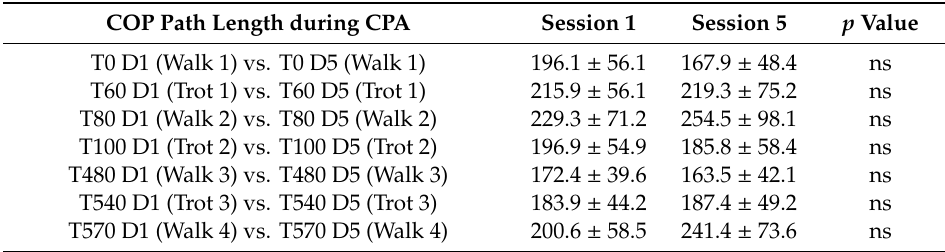
Table 3. Comparison of COP path length and COP average radial displacement values during compensatory postural adjustment (CPA) between corresponding times of session 1 and 5 when pace changes (3 seconds interval after change). D1 corresponds to session 1 and D5 to session 5. Values correspond to means ± SD of the mean. p < 0.001 (***).